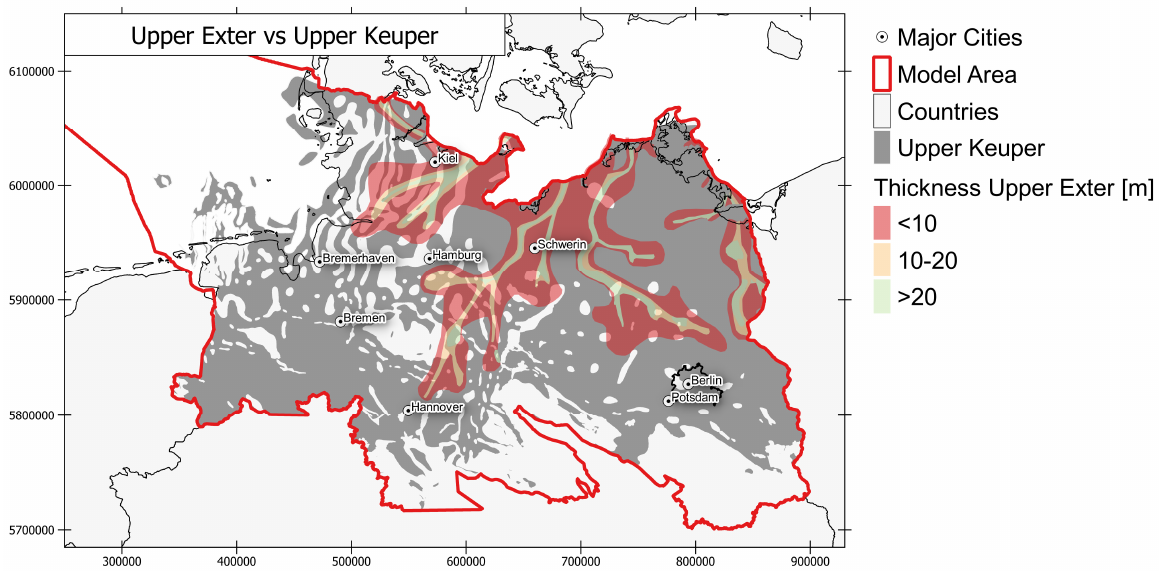
Figure 9. Conflicting extent of the Upper Exter Formation contained in the Upper Keuper